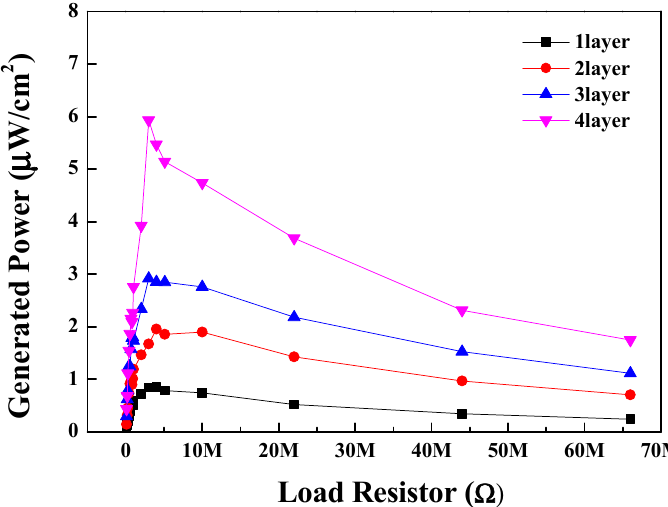
Figure 9. Generated power of the multilayered BS-PT piezoelectric energy harvesters depending on the load resistors for the mechanical force of 500 N. Table 3. Generated power of the 1–4 layer BS-PT piezoelectric energy harvesters.